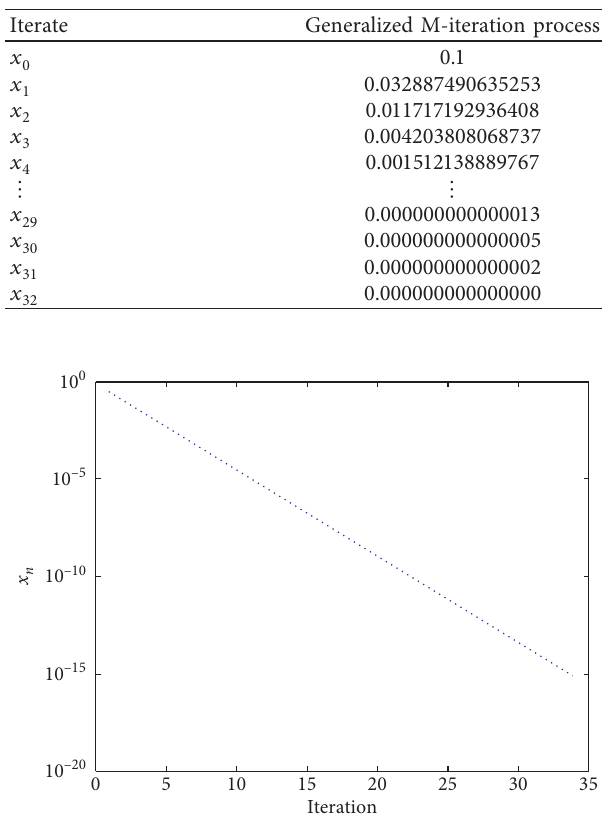
Table 1: Sequence generated by generalized M-iteration process.